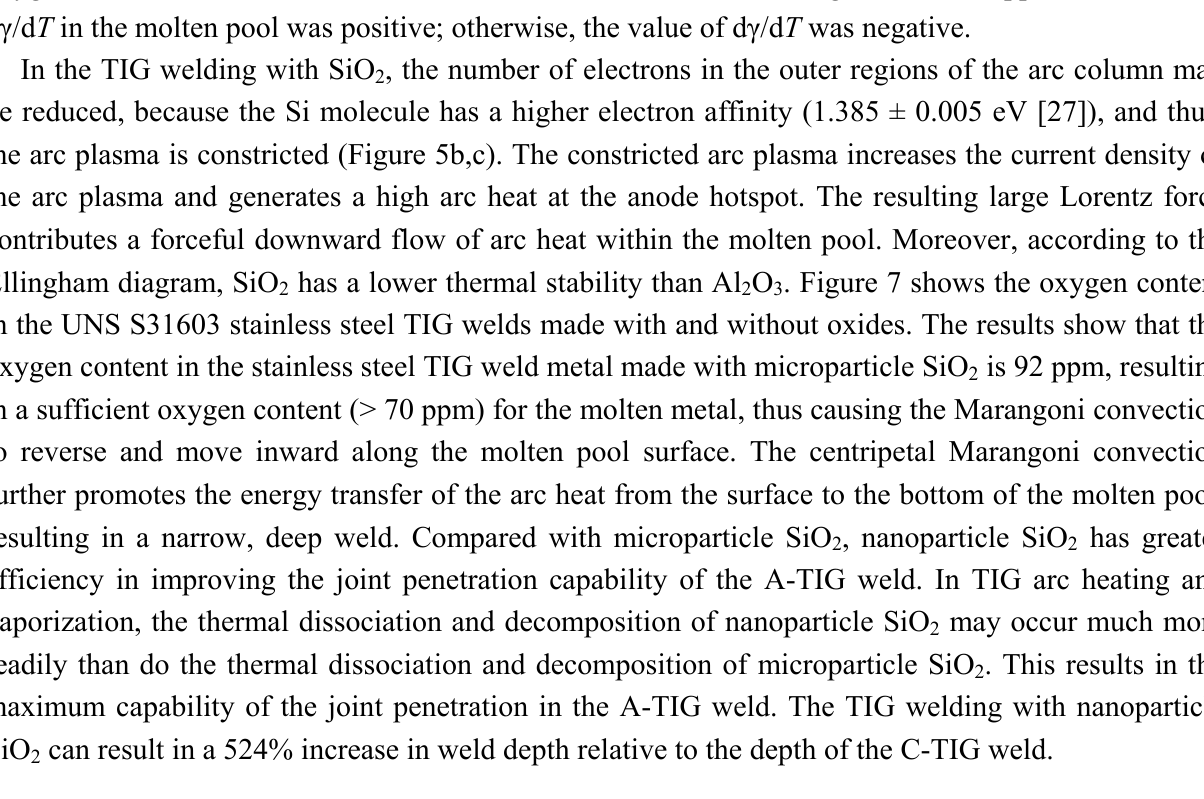
Figure 7. Oxygen content in TIG welds made with and without